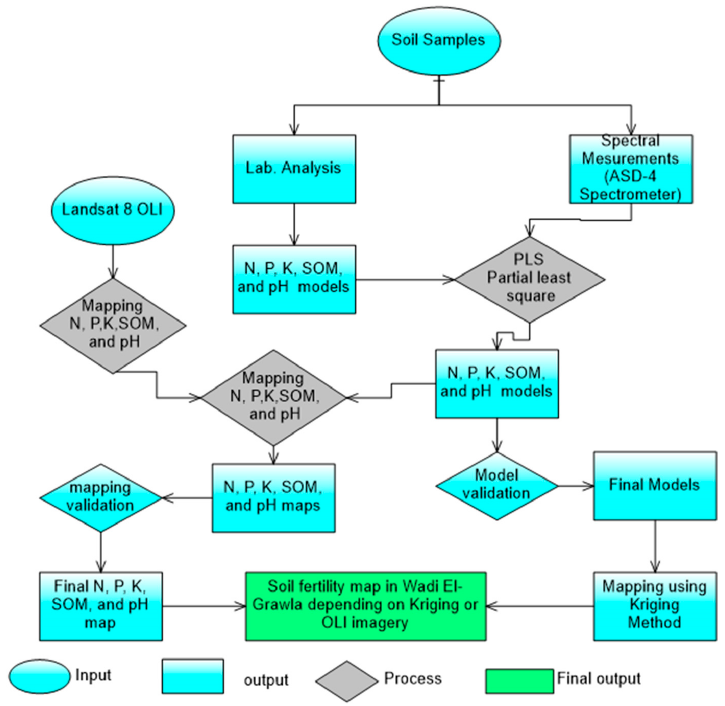
Table 2. Criteria of soil fertility and their factor score.